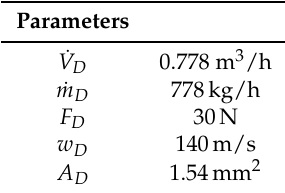
Table 1. Parameter values for Equation (2).